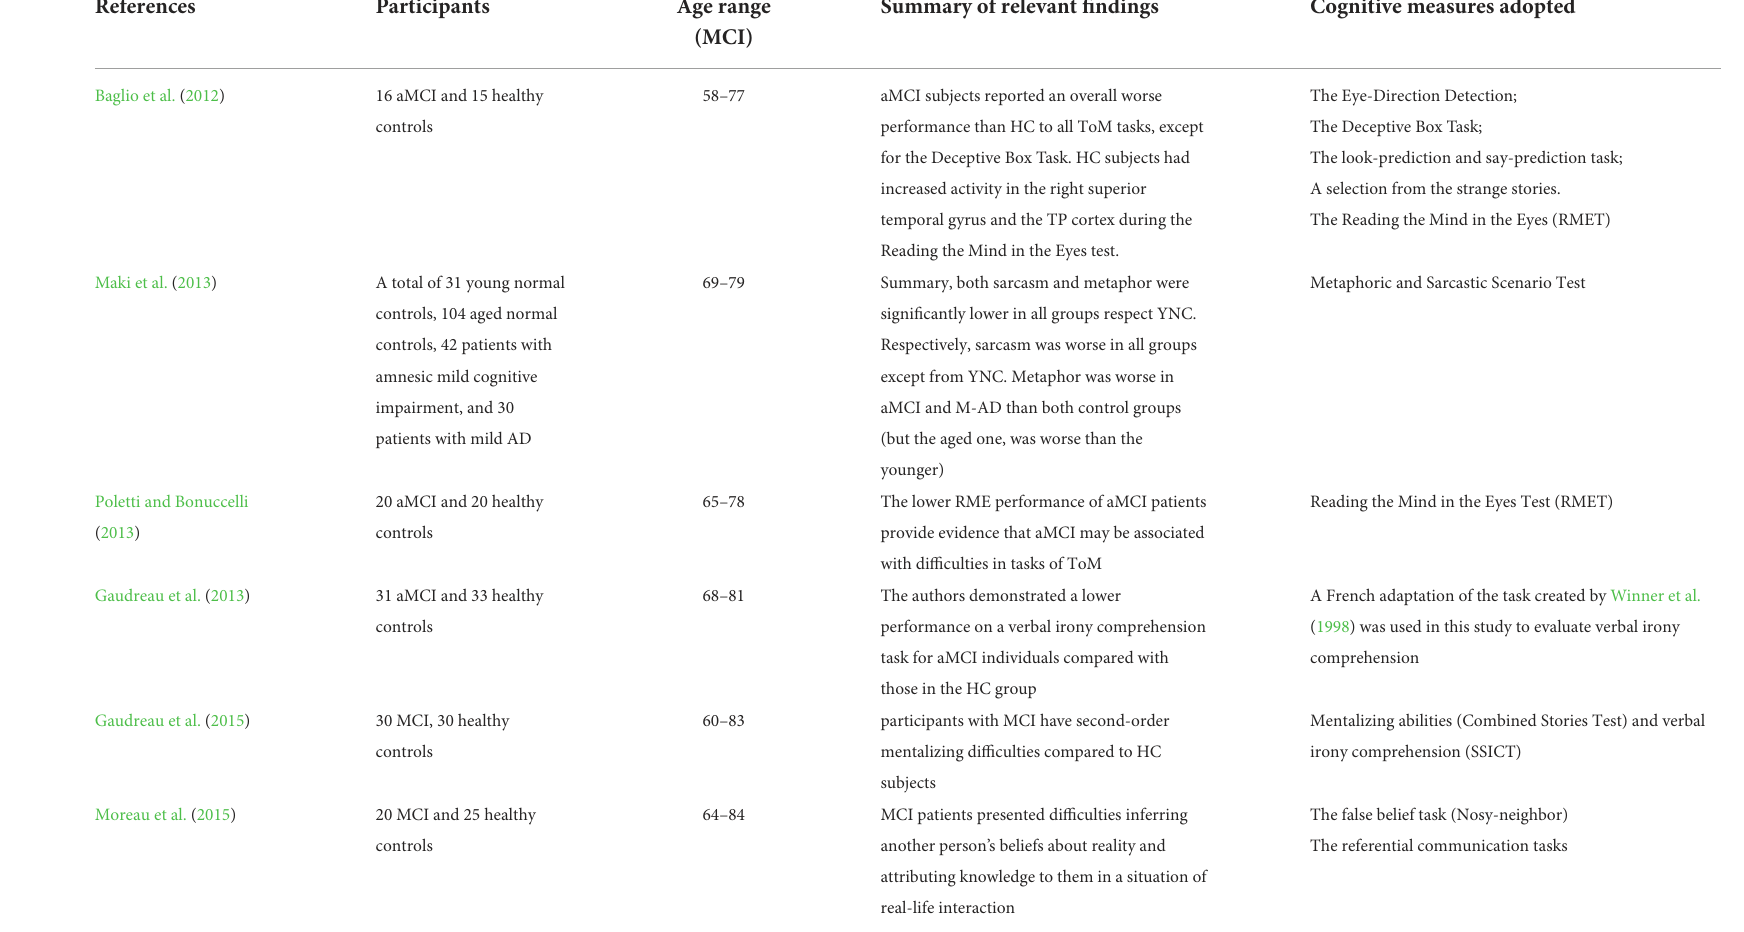
TABLE 1 Theory of mind ( N =